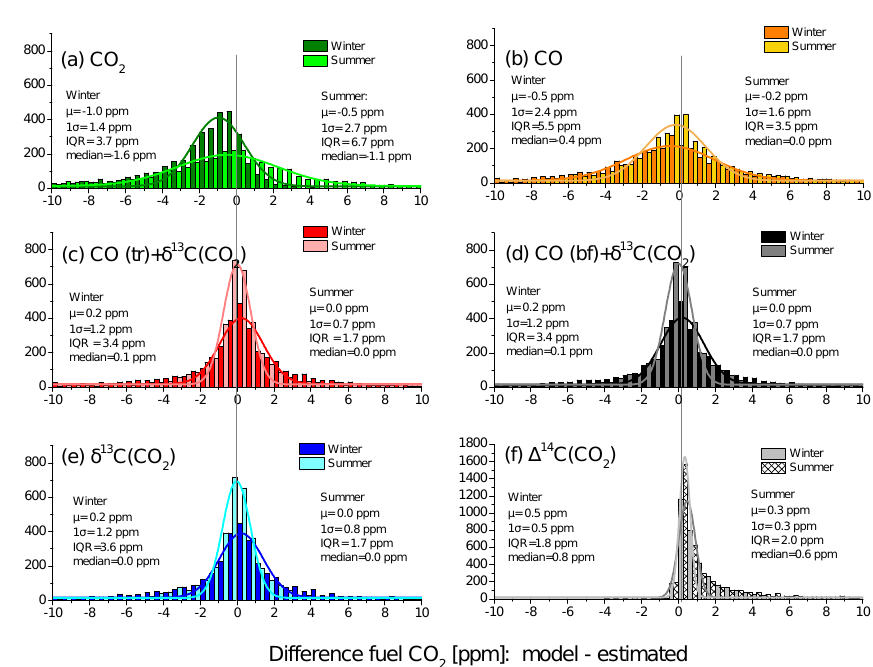
Figure 3. Same as Fig. 1 but for Berlin. In Berlin, mean fuel CO 2 for summer is 23µmolmol − 1 and that for winter is 27µmolmol − 1 .